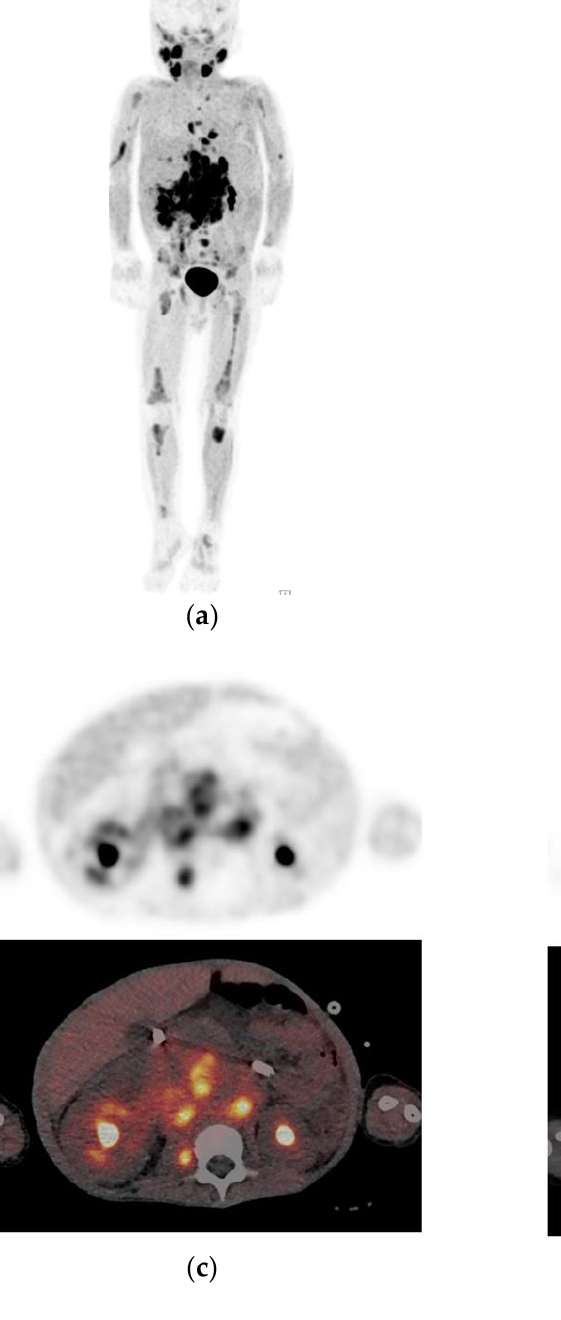
Figure 2. Example of a neuroblastoma patient with extensive metastasis who underwent [ 123 I]mIBG and [ 18 F]mFBG imaging within 1 day. These figures illustrate the superior image quality and tumor delineation of ( a ) [ 18 F]mFBG PET maximum intensity projection and ( c ) axial PET-CT due to higher spatial resolution, higher tumor-to-background contrast, and improved counting statistics compared to ( b ) [ 123 I]mIBG planar scintigraphy and ( d ) axial single-photon emission computed tomography with computed tomography